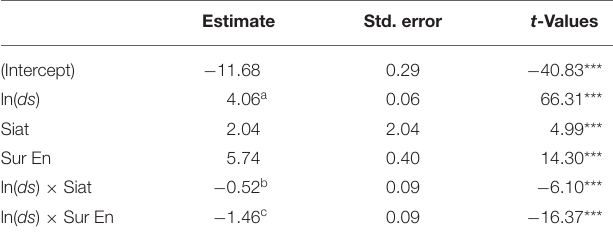
TABLE 3 | Estimated fixed effects for the long-term allometry ( α ) model (1970–2016) with the response variable ln( dr ) of the stand interior trees ( n = 37) in relation to ln( ds ) and site [Furna, Siat, and Sur En; Equation (4)], with dr and ds being the root and stem radii